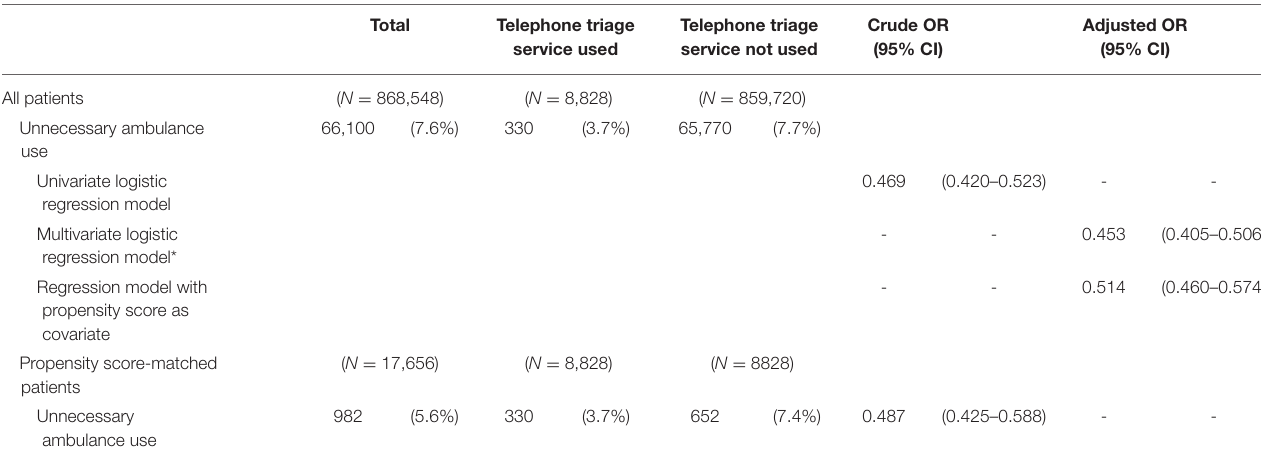
TABLE 2 | Unnecessary ambulance use with or without telephone triage